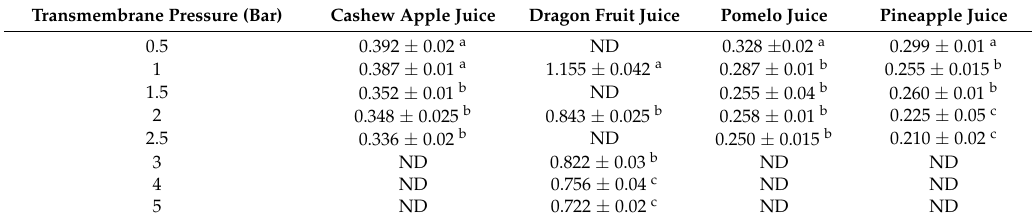
Figure 9. Effect of TMP on permeate flux of pineapple juice ( T = 30 °C; membrane = 500 nm). Table 4. Effect of transmembrane pressure on turbidity of permeate. Transmembrane Pressure (Bar) Cashew Apple Juice Dragon Fruit Juice